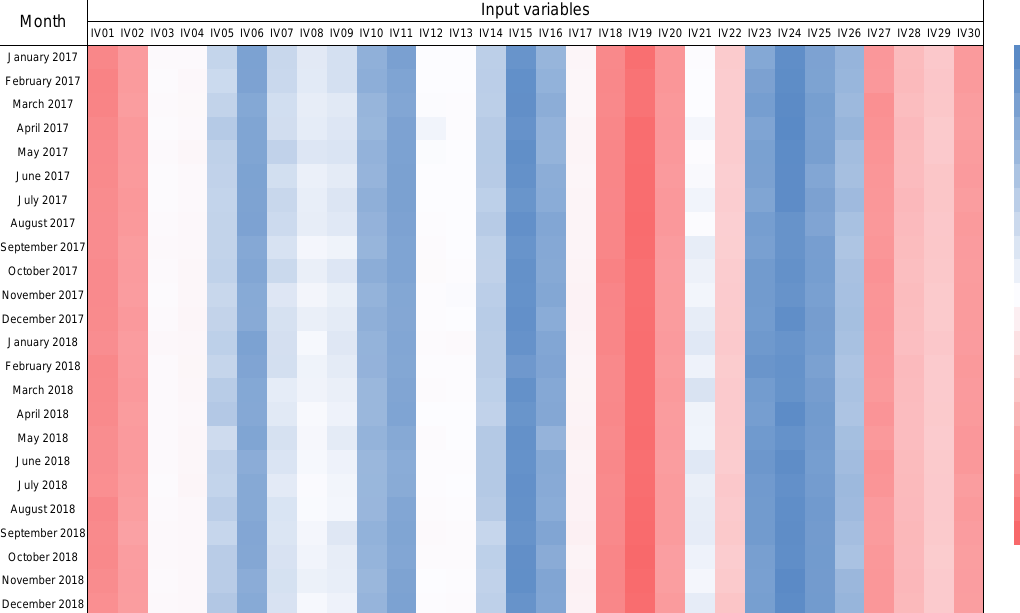
Figure 15. Result of feature importance via time-series cross-validation using the input variables in Table 2 for Gosan-ri. A cooler color indicates a lower feature importance value, whereas a warmer color indicates a higher feature importance value. 4. Conclusions In this paper, we proposed an MSA global solar radiation forecasting method based on LightGBM. To do this, we first configured 330 input variables considering the time and weather information provided by KMA to forecast the global solar radiation at multiple time points over the next 24 hours. Then, we constructed a LightGBM-based forecasting model with DART boosting. To